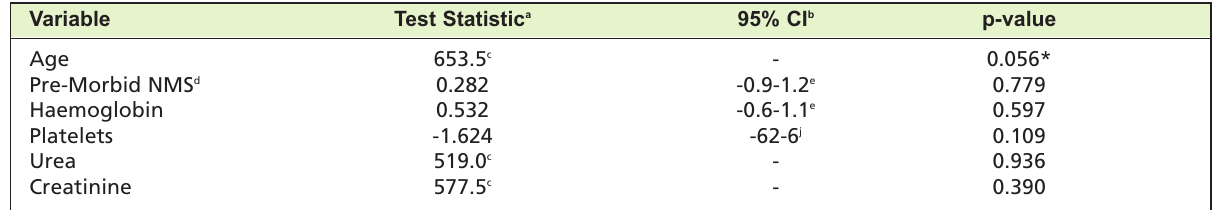
(a) Univariate analyses of potential continuous predictive variables for inpatient morbidity. (b) Univariate analyses of Table V: potential categorical predictive variables for inpatient